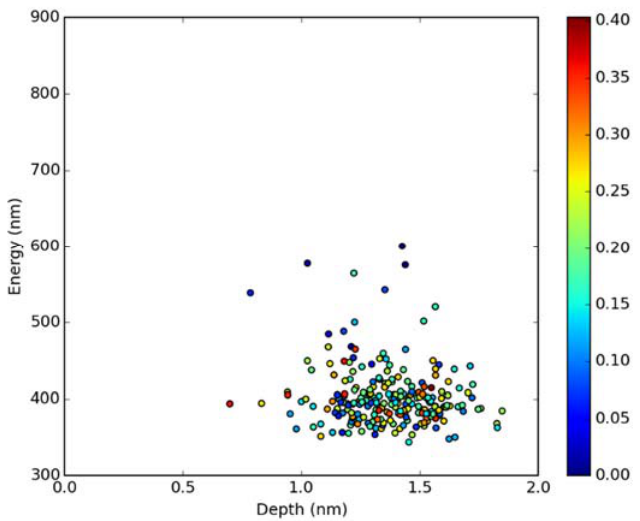
Figure 11. Emission energy vs fluorophore depth in DPPC bilayer. Oscillatory strength is color ‐ coded.